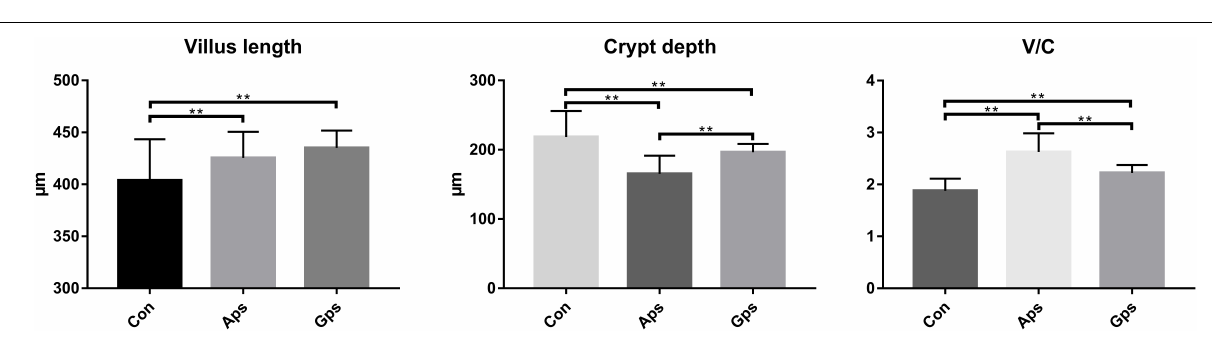
FIGURE 3 | Effect of the Aps and Gps on jejunum villus of weaned piglets. A represents the villus length in the jejunum of weaned piglets. B represents the crypt depth in the jejunum of weaned piglets. C represents the ratio of the villus length and crypt depth. Con represents the control piglets; Aps represents the piglets supplemented with the astragalus polysaccharide; Gps represents the piglets supplemented with ginseng polysaccharide. ∗∗ Means significant difference ( P < 0.01). Values means n = 10 for the analysis of the jejunum